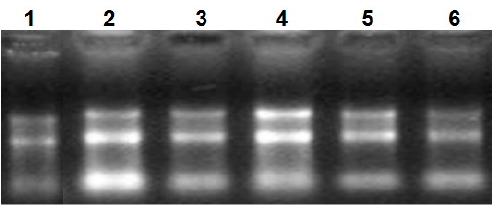
Figure 1. The electrophoretogram of RNA. From1 to 6, the results represent heart tissue, liver tissue, small intestine tissue, longissimus dorsi tissue, hind shin tissue, adipose tissue, respectively.